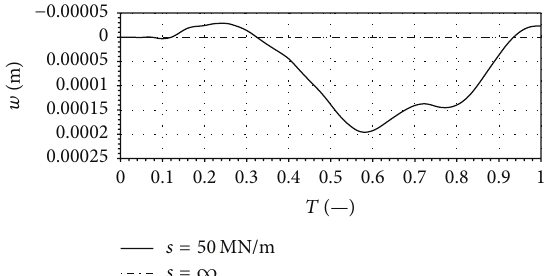
Figure 24: Dynamic deflection of point “a” (middle of the first span).